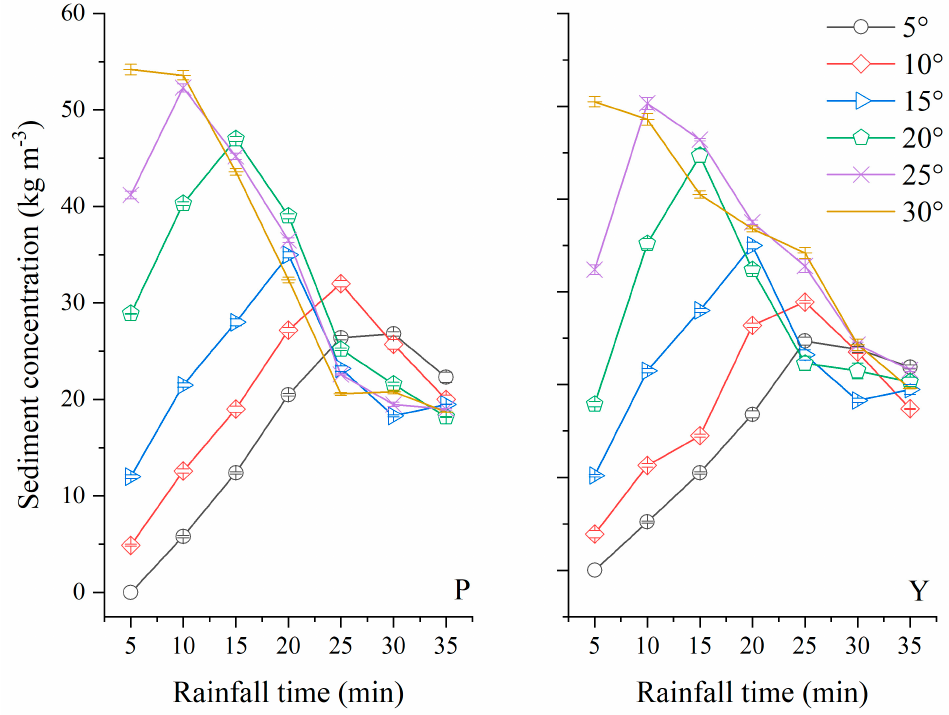
Figure 4. Sediment concentration in runoff with rainfall time under different slope gradients in rainfall intensity of 3.0 mm min − 1 (P represents purple soil, Y represents yellow soil).